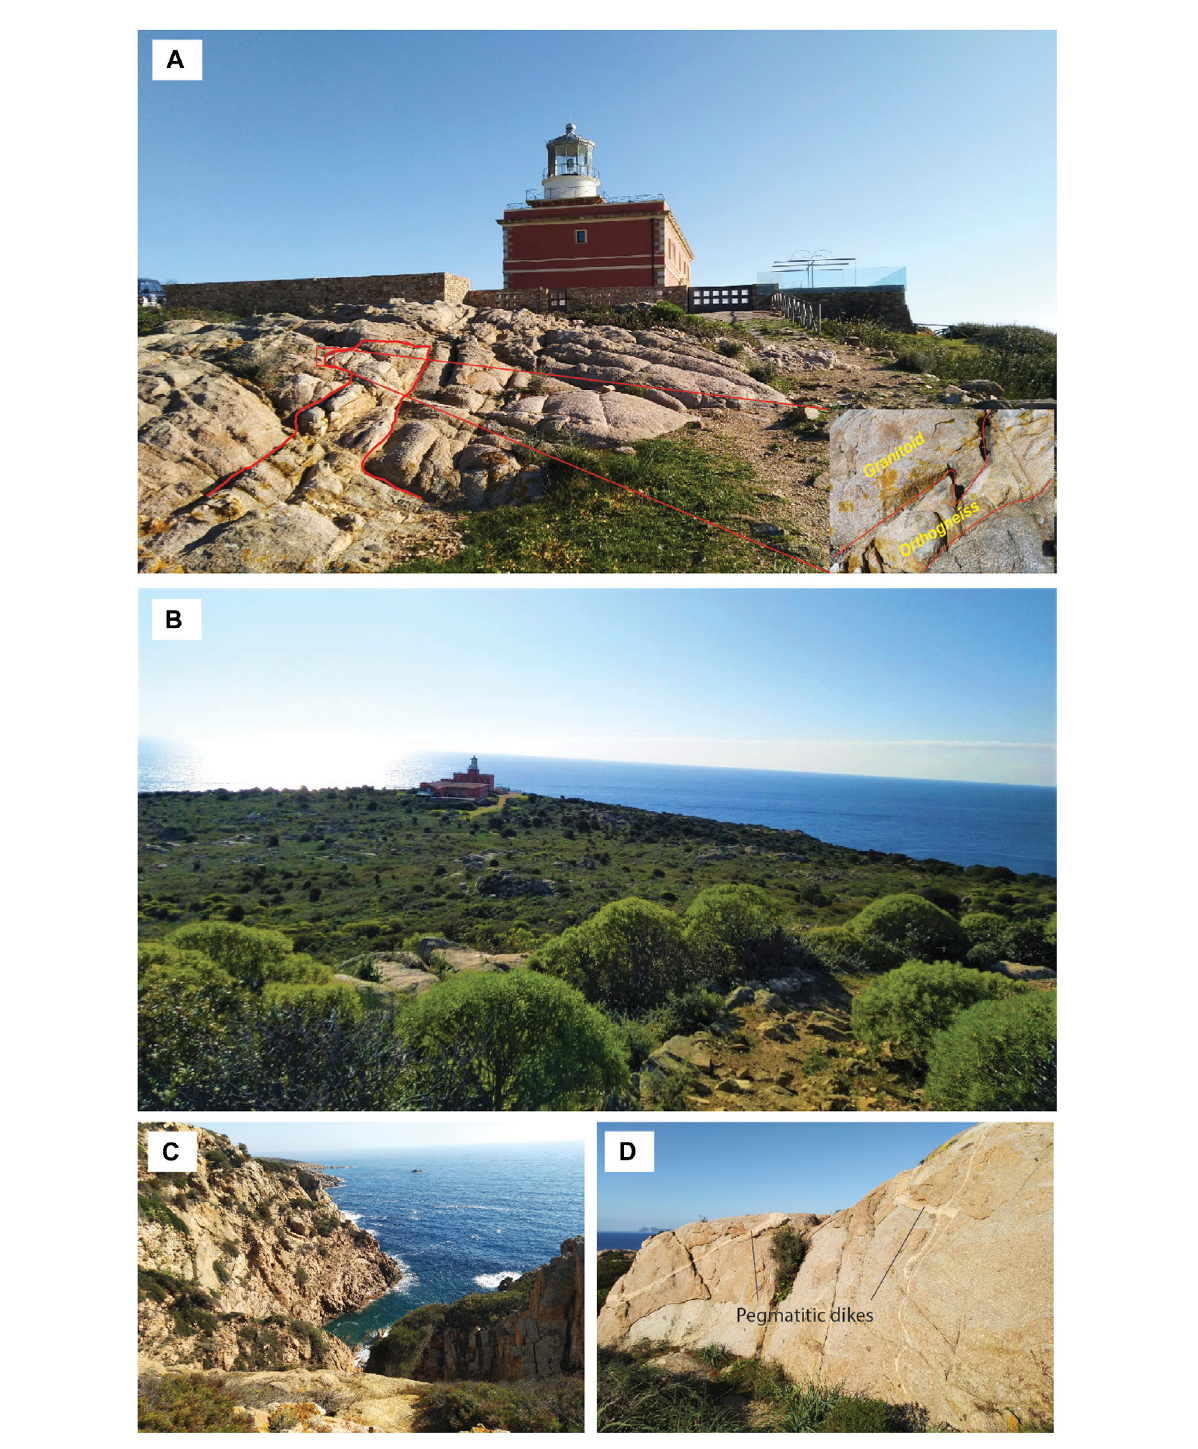
FIGURE 6 (A) Viewofthelighthouseinthebackgroundand,infront,the MonteFilau orthogneissintrudedbyVariscangranitoids; (B) viewofthelighthouse and Capo Spartivento from the road that leads to Mt. Sa Guardia Manna ; (C) high, sub-vertical, incised cliffs, few dozen meters south of the lighthouse; (D) granitoid body, about 100 m north-west of the lighthouse, with centimeter-thick